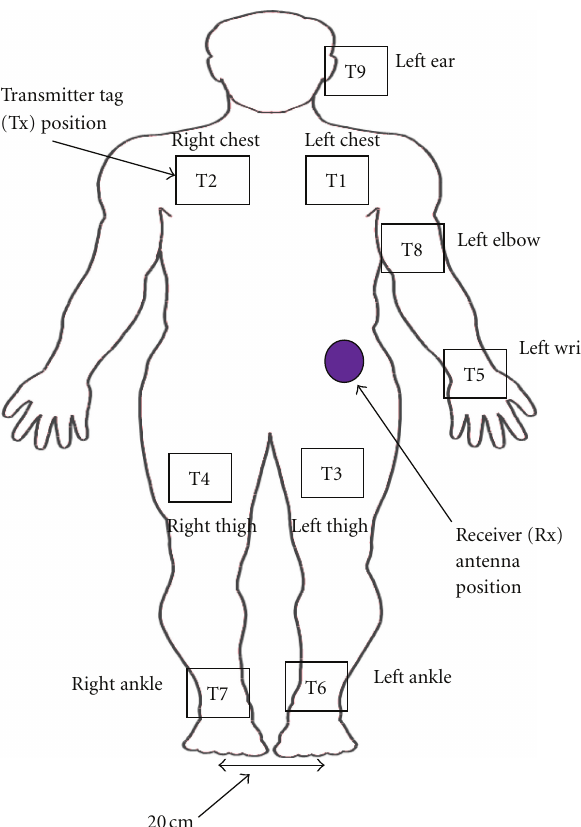
Figure 1: On-body measurement settings showing the receiver antenna is on the left waist, and nine transmitter tags are on di ff erent locations of the body (nine static and dynamic channels cases